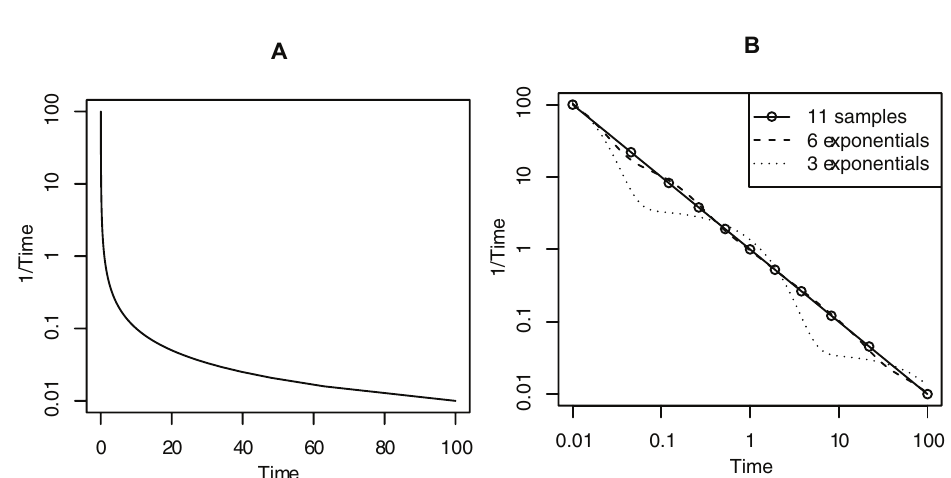
Figure 1. A : function y ( t ) = 1/ t , and B : approximations obtained by fitting six and three exponentials to the depicted eleven samples. Note the log-lin and log-log scales for panels A and B , respectively. Time has arbitrary